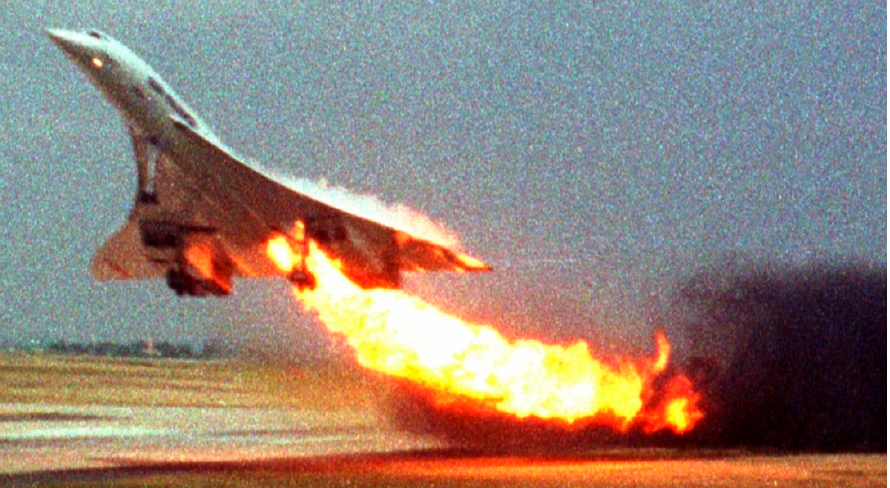
Figure 3. The burning engine with a bollard sucked in. Source: [7].